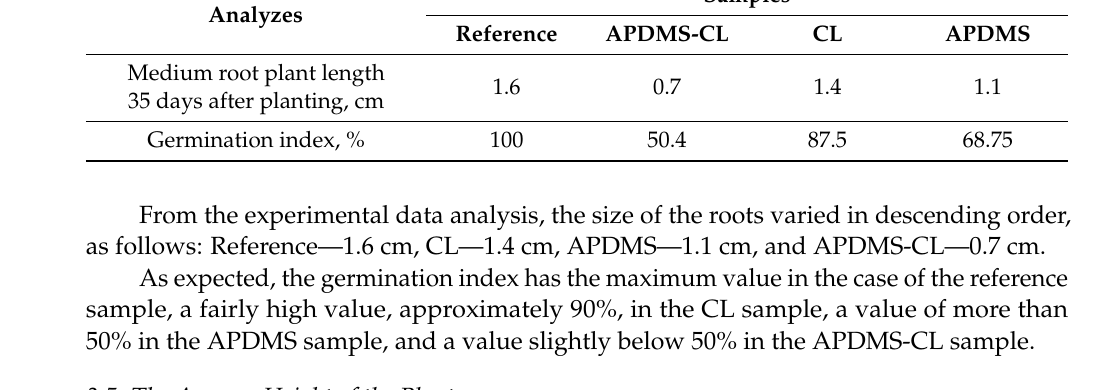
Table 1. The average length of plant roots and germination index .